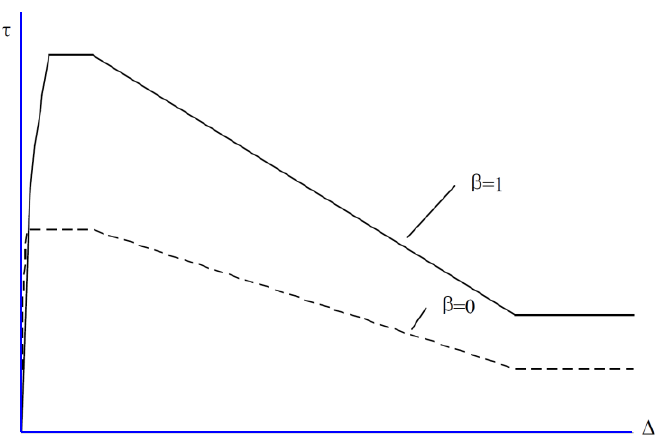
Figure 11. Eligehausen bond stress-slip response.